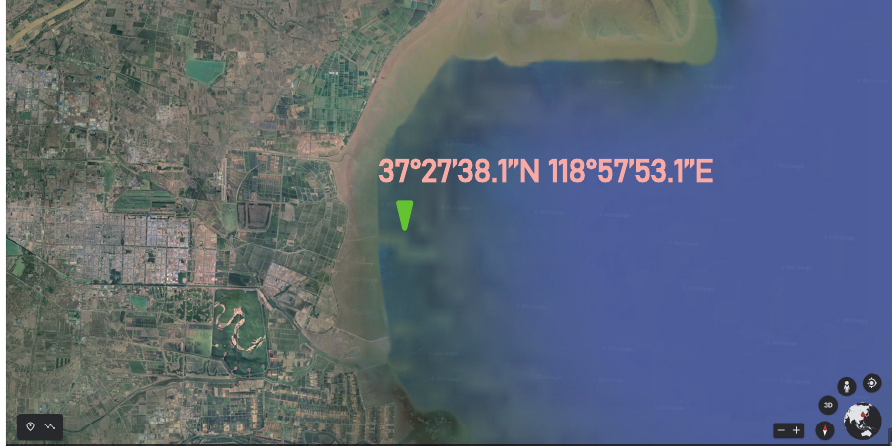
Figure 13. Aerial image (Google Earth) of the experimental site. The direct signals are received using an RHCP L1/B1 antenna in the zenith